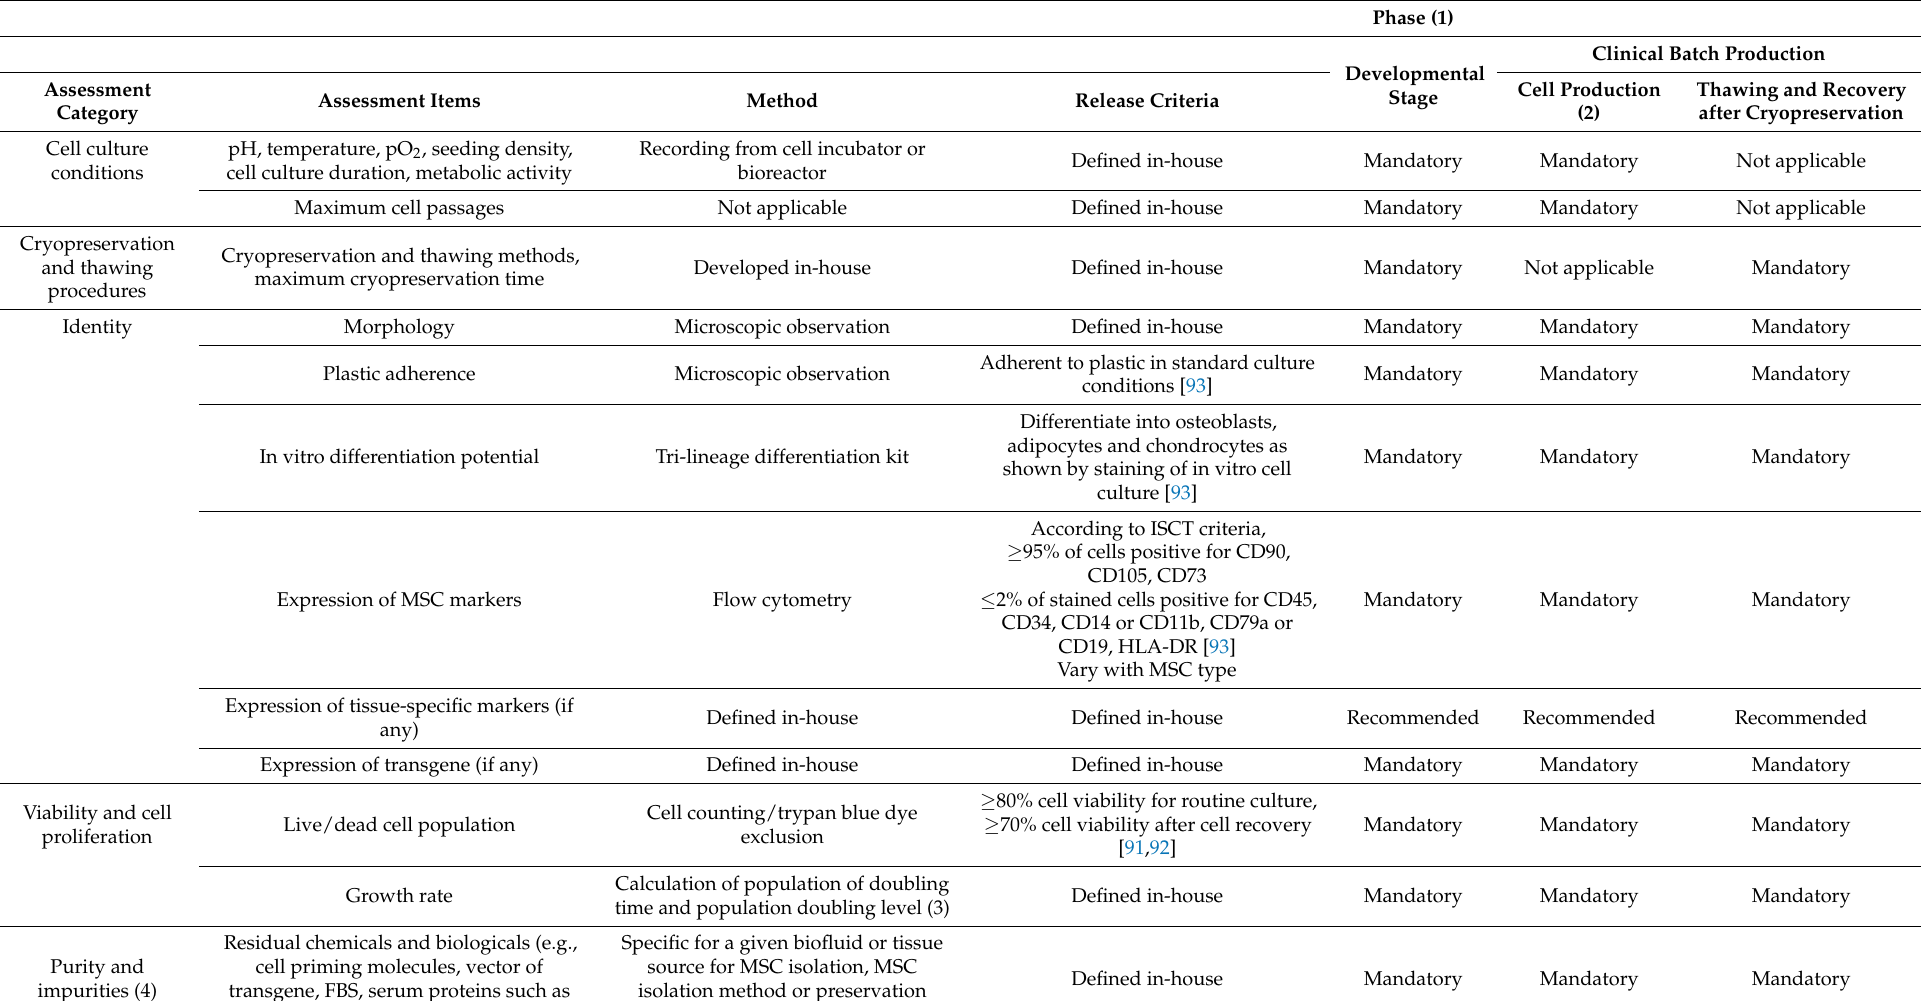
Table 3. Suggested QC panel of parent MSC bank for EV production [69,91–93,101–105].